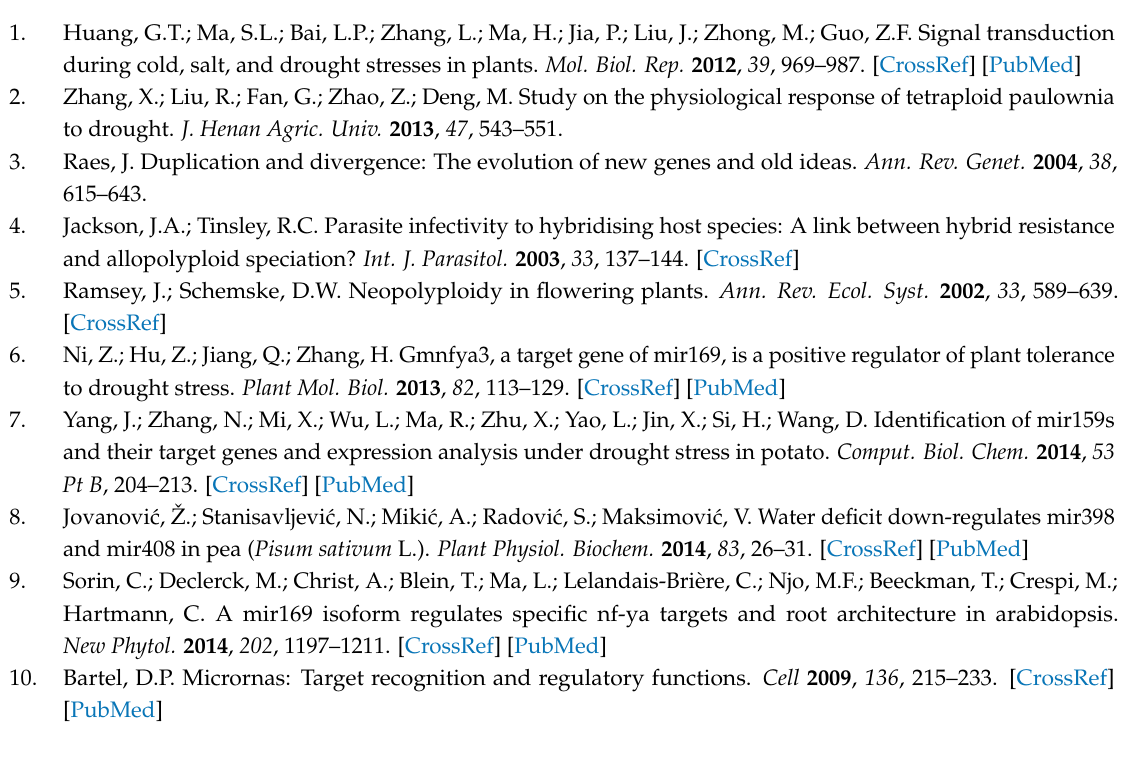
Table S1: Quantitative RT-PCR primers for genes and miRNAs. Table S2: Comparison of the differentially expressed genes in PF2 vs. PF2T_12D. Table S3: Comparison of the differentially expressed genes in PF4 vs. PF4T_12D. Table S4: Comparison of the differentially expressed genes in PF2 vs. PF4. Table S5: Comparison of the differentially expressed genes in PF2T_12D vs. PF4T_12D. Table S6: Comparison of the KEGG annotation Table S8: Comparisons of the consistently differentially expressed genes in PF2 vs. PF2T_12D and PF4 vs. PF4T_12D. Table S9: Comparisons of the consistently differentially expressed genes in PF2 vs. PF4 and PF2T_12D vs. PF4T_12D. Table S10: The DEGs of type I in two P. fortunei genotypes. Table S11: KEGG annotation for the type I DEGs in two P. fortunei genotypes. Table S12: The conserved miRNAs identified in two P. fortunei genotypes. Table S13: The novel miRNAs identified in two P. fortunei genotypes. Table S14: Identified miRNA target genes in P. fortunei by degradome analysis. Figure S1: Gene Ontology of the DEGs in PF2 vs. PF2T_12D. Figure S2: Gene Ontology of the DEGs in PF4 vs. PF4T_12D. Figure S3: The correlation coefficient of DEGs between two P. fortunei genotypes. Figure S4: The schematic representation of transcription factors involved in drought-stress-responses. Acknowledgments: We thank Beijing Genomics Institute-Shenzhen (BGI-Shenzhen) for helping us with the throughput RNA-seq and sRNA-seq analyses. We also thank Edanz China for assistance with the language